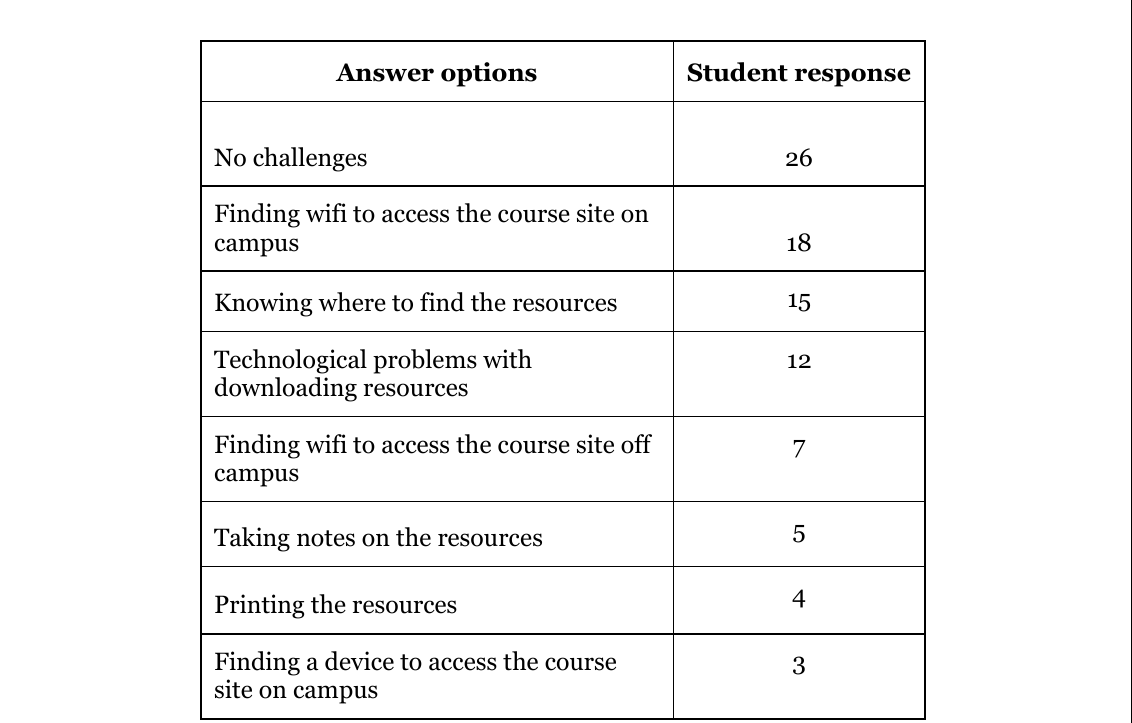
Reported Challenges Associated with Accessing Materials from the OER